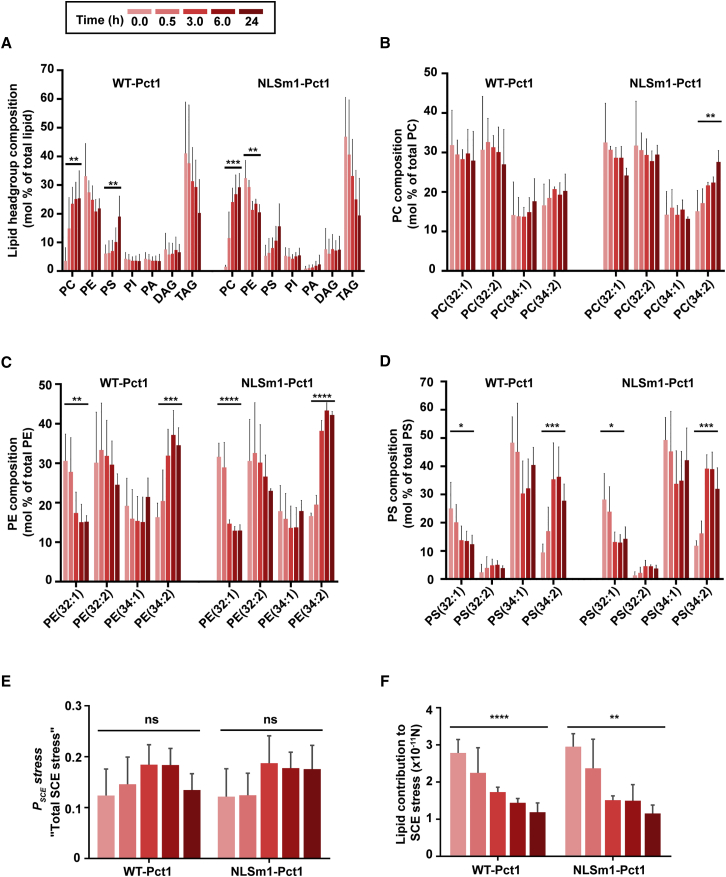
Data-Driven Modeling of SCE Stress Regulation from the Lipidomes of 3Δ Cells Expressing WT Pct1-GFP or NLSm1-Pct1-GFP and Undergoing PC Recovery(A–F) 3Δ yeast cells expressing either WT Pct1-GFP or Pct1-NLSm1-GFP were grown for 24 hr followed by addition of 1 mM choline. Cells were collected before (0.0 hr) and after choline supplementation at the indicated time points (see top left inset for time point color codes) for lipidomics analyses and the total (PSCE) and lipid-driven SCE stress in the cells was calculated as described in the STAR Methods. These data correlate with the imaging slides shown in Figures 5 and 6.(A) Lipid composition by head group (mol% total lipid). PC, phosphatidylcholine; PE, phospatidylethanolamine; PS, phosphatidylserine; PI, phosphatidylinositol; PA, phosphatidic acid; DAG, diacylglycerol; TAG, triacylglycerol.(B–D) FA composition of the PC (A), PE (B), and PS (C) fraction expressed as mol% of the respective total PL. The PL (32:1) or (34:1) represent species where the acyl groups at C-1 and C-2 contain a total of 32 or 34 carbon atoms with one double bond, while the PL species (32:2) or (34:2) represent species with two double bonds.(E) Estimates of the total SCE stress (PSCEstress).(F) Estimates of the lipid contribution to SCE stress.All data are means ± SD of three to four experimental repeats. One-way ANOVA, ∗p < 0.05, ∗∗p < 0.01, ∗∗∗p < 0.001, ∗∗∗∗p < 0.0001. See Figure S7.